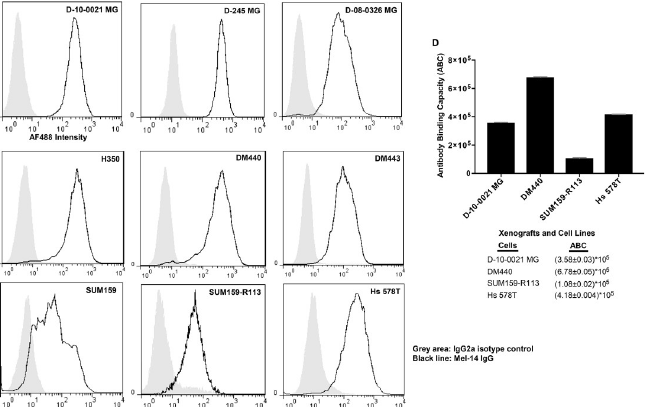
Fig 1. CSPG-4 expression in human tumors. A-C. Flow cytometry analysis of CSPG-4 expression on GBM xenografts (A), melanoma cell lines (B), and breast cancer cell lines (C). D. Quantitative flow cytometry (Q-FACS) analysis of CSPG-4 binding capacity on selected xenografts and cell lines. The values represent the average of 2 experiments, and the error bars represent SEM.